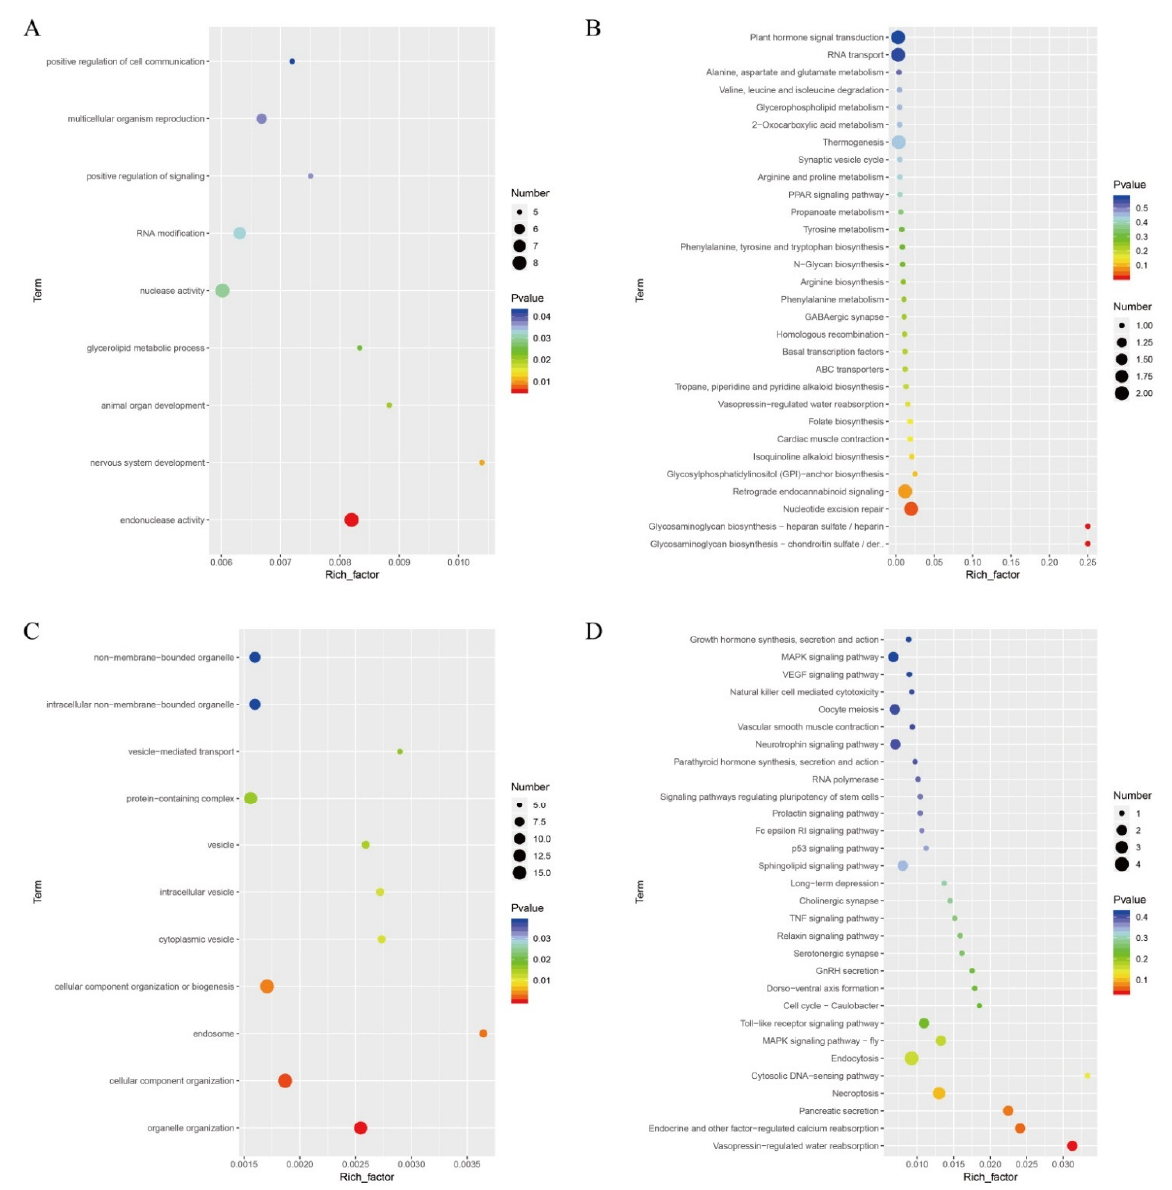
Figure 5. Bubble charts of enrichment for two types of orthologous genes. ( A ) GO enrichment of divergent genes. ( B ) KEGG enrichment of divergent genes. ( C ) GO enrichment of conserved genes. ( D ) KEGG enrichment of conserved genes.